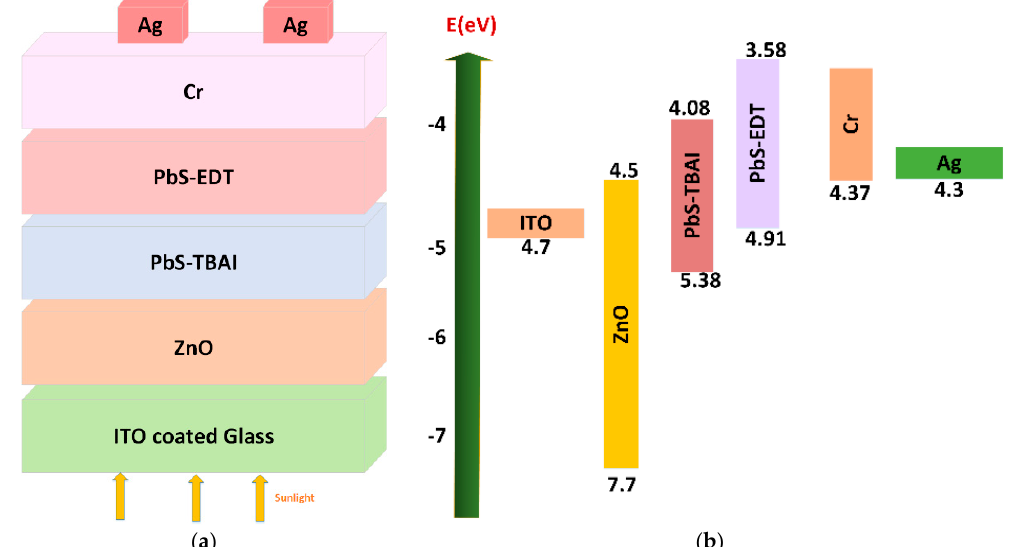
Figure 1. ( a ) Schematic diagram and ( b ) energy level diagram of the PbS quantum dot (QD) photovoltaic device used in this study.